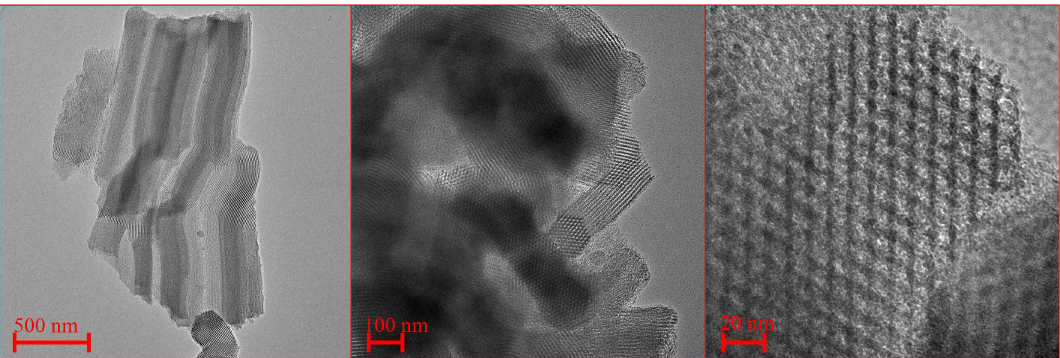
Figure 9. TEM micrographs of SBA-15